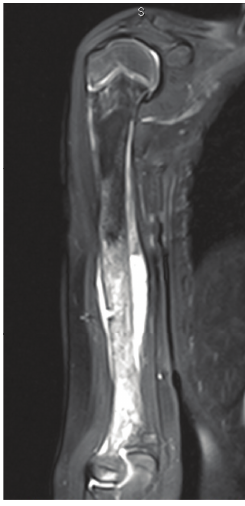
Figure 2: MRI of humerus demonstrating osteosarcoma lesion.